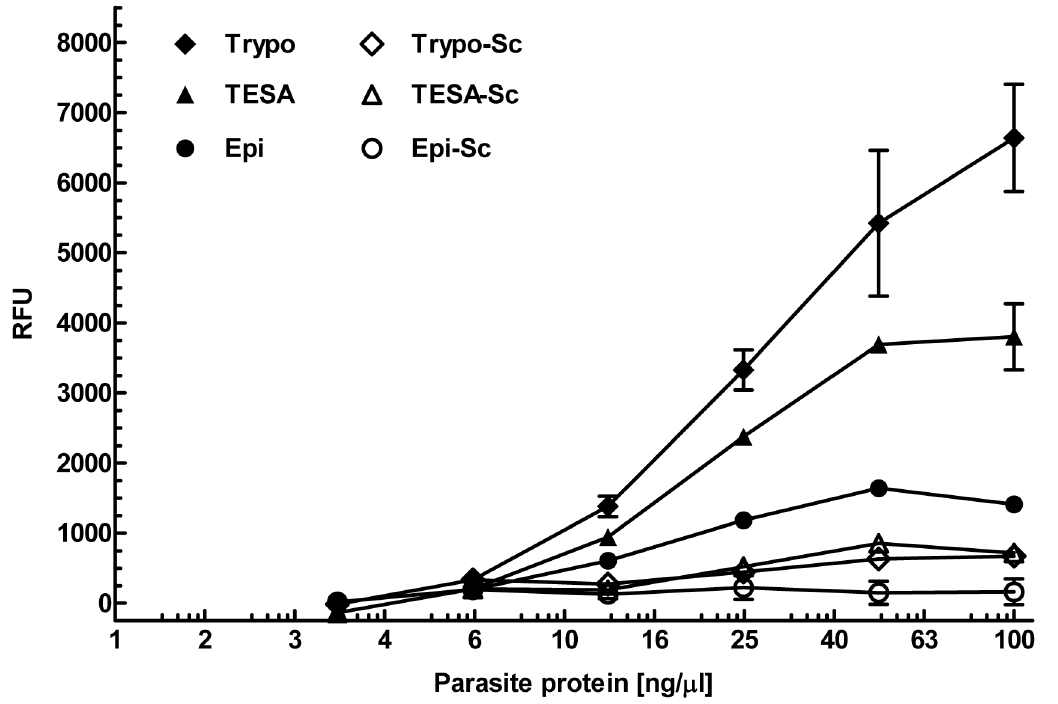
Figure 3. Aptamer L44 binds predominantly to TESA and protein extracts from T.cruzi trypomastigotes. 100 nM biotinylated Apt-L44 was used to perform an ELA assay in a polystyrene 96 well plate coated with 50 m l/well of decreasing amounts, beginning at a concentration of 100 ng/ m l, of TESA and trypomastigote extracts (Trypo) from T. cruzi Tulahuen strain, and epimastigote extracts (Epi) from T. cruzi Y2 strain. Signal generated, relative fluorescence units (RFU), are plotted on the Y-axis and each point represents the mean of duplicate values with standard deviation. Biotinylated Apt-L44 showed significant binding to TESA and trypomastigote protein extracts while minimal binding was observed to epimastigote extract. As a control scrambled biotinylated Apt-L44 was used and did not show any binding to the parasite proteins (Trypo-Sc, TESA-Sc and Epi-Sc).